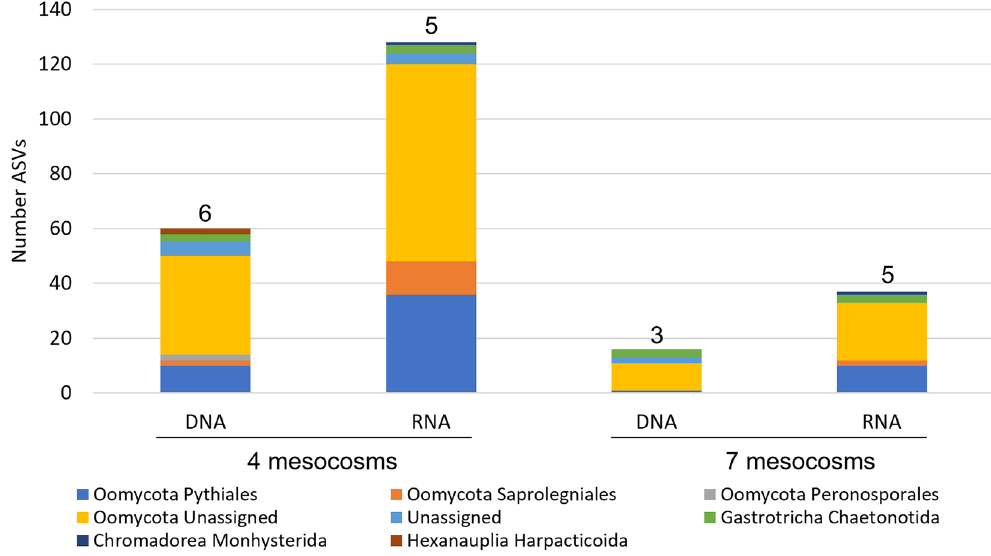
Figure 3. Assigned taxonomy and number of unique sequences (ASVs) detected using the COI marker for RNA and DNA templates in four and all seven mesocosms. Total number of detected taxa at the Order level for each marker and template stated above the bar. Taxonomy is assigned to